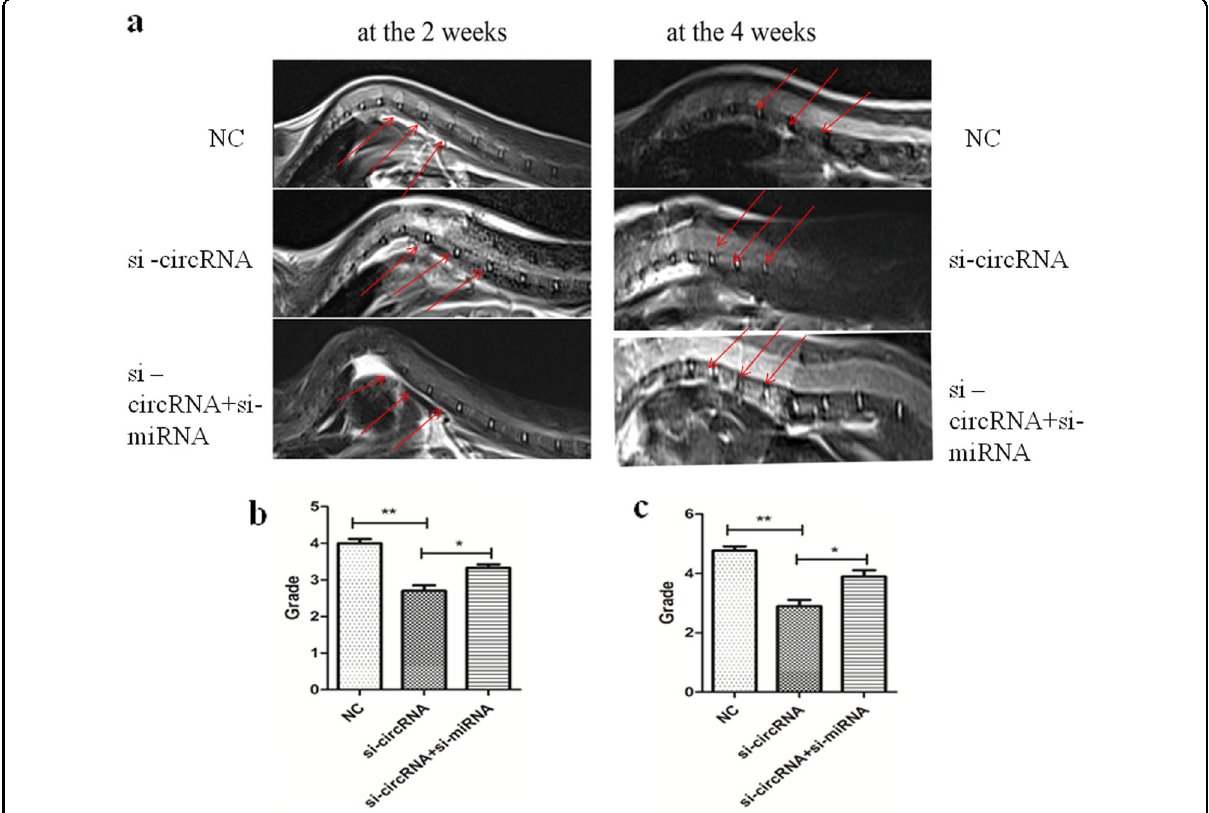
Fig. 6 MRI evaluation in circRNA_104670 or circRNA_104670 with miR-17-3p gene inhibition mice at the 2 and 4 weeks. a Three representative T2-weighted magnetic resonance images from each group (the original in-plane resolution is 135.47 mm × 135.47 mm) at 2 (left panels) and 4 (right panels) weeks after gene inhibition of mice are shown. b , c Quantitative data of the MRI grades in three groups ( n = 8/group) at 2 ( b ) and 4 ( c ) weeks after the birth of the mice are shown. * p < 0.05, ** p <